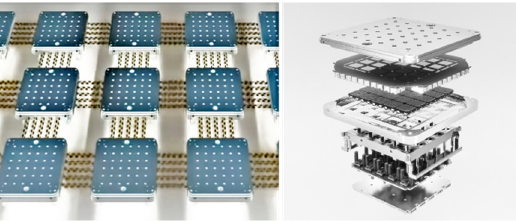
Figure 1. A set of D1 Dojo processors (2021) for Tesla’s AI autopilot, designed to work in neural networks (left). The design of the processor, consisting of various plates: heat sink, computation, and power and control (right).